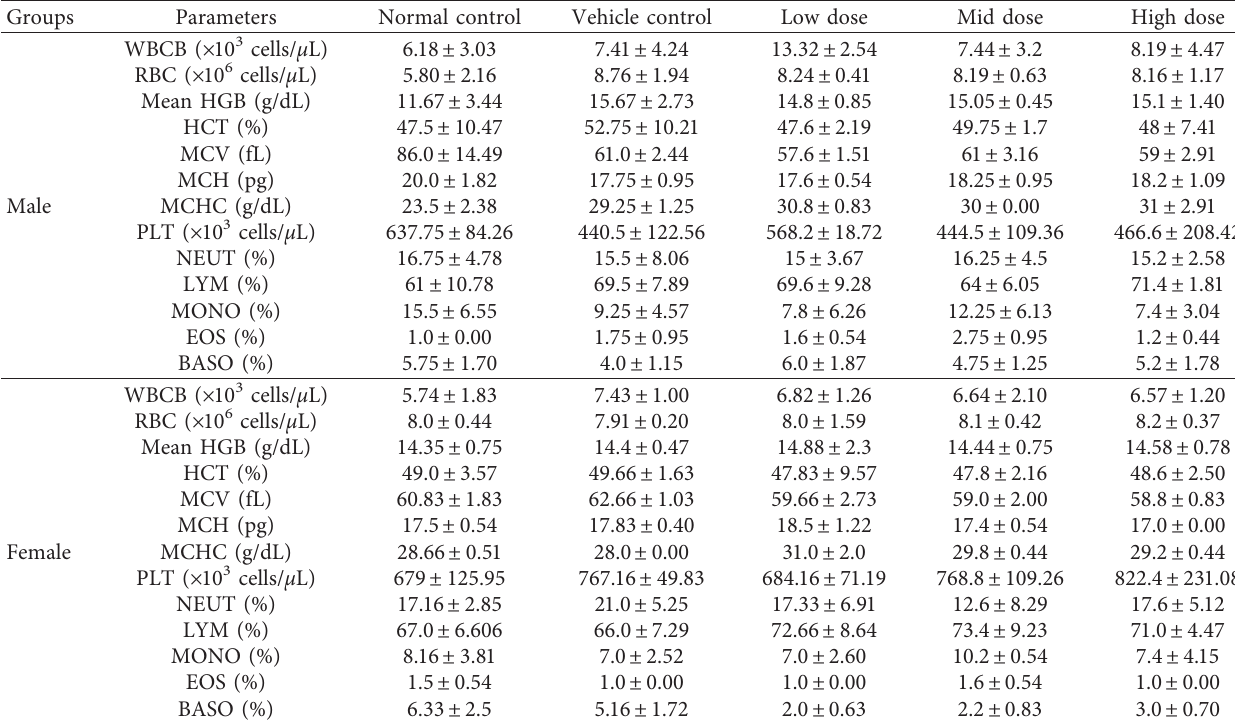
Table 3: Evaluation of hematological parameters in the inhalation subacute toxicity study of AND-2-HyP- β -CYD complex.